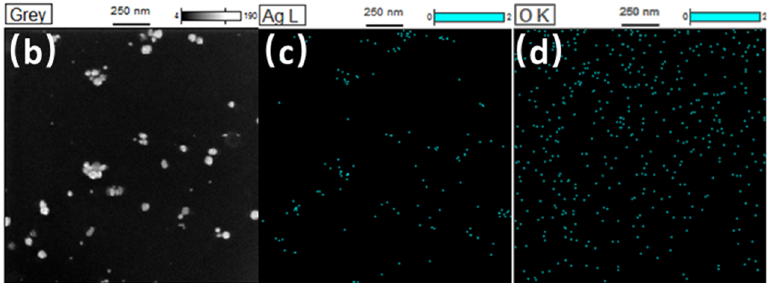
Figure 5. EDX spectra ( a ) and dark-field TEM image of Ag NPs ( b ) with the corresponding EDX map for silver ( c ) and oxygen ( d ) (ultrasonic frequency: 100 kHz, ultrasonic time: 120 min).